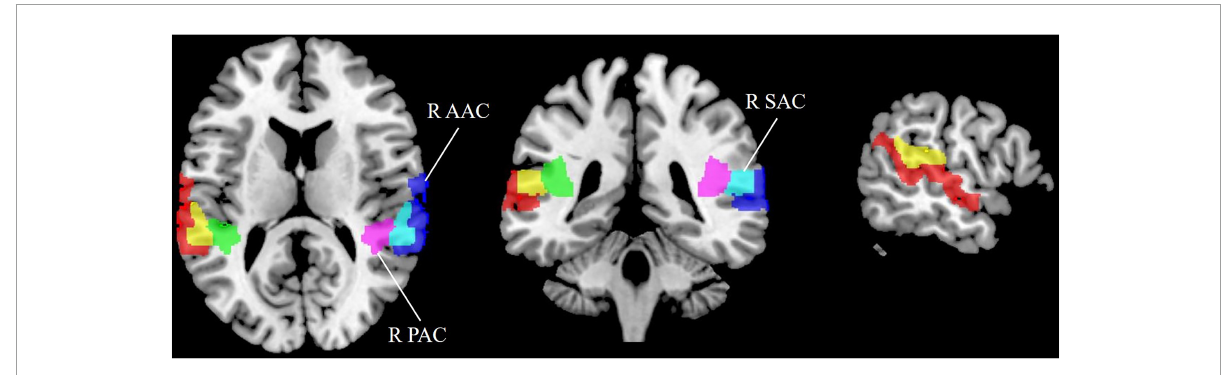
FIGURE1 Region of interest (ROI) analysis for quantitative evaluation of CBF in the auditory cortex. SAC, secondary auditory cortex; AAC, auditory associative cortex; PAC, primary auditory cortex; CBF, cerebral blood flow; R, right; L,